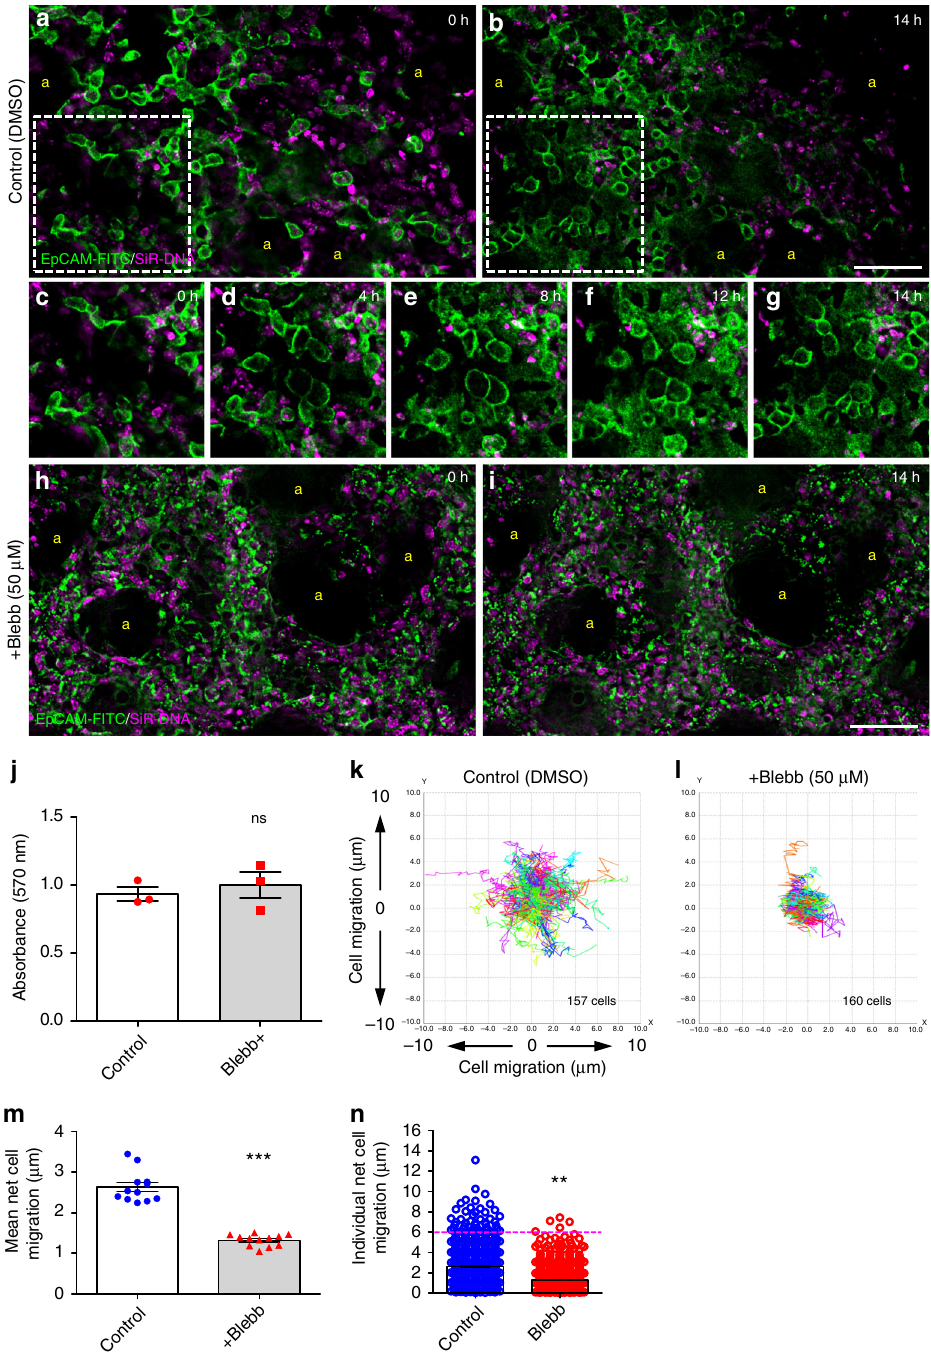
Fig. 6 Blebbistatin inhibits epithelial cell migration in PCLS. Deconvolved wide fi eld, single plane z-stack images from 14 h time-lapse videos (Supplementary movies 14A, B) of control ( a – g ) and blebbistatin-treated ( h , i ) P3 PCLS labelled with EpCAM-FITC (green) and SiR-DNA (magenta). Still images are taken from supplementary video 14A at 0 ( c ), 4 ( d ), 8 ( e ) 12 ( f ) and 14 ( g ) hours represent the white boxed regions in a and b . Scale bar = 50 µ m. MTT cell viability assay comparing control and blebbistatin-treated P3 PCLS at the end of time-lapse, ( j ), n = 3 independent experiments using three separate mice, with duplicate slices per condition, per experiment, ns = not signi fi cant; paired Student t -test. Individual cell tracking over 14 h in a single fi eld from P3 PCLS treated with control DMSO ( k ) or blebbistatin ( l ) containing media. Mean net epithelial cell migration in P3 control and blebbistatin-treated PCLS movies over 14 h ( m ). n = 3 independent experiments using three separate mice, with duplicate slices per condition, per experiment. Two fi elds were quanti fi ed per slice. Each dot represents mean net epithelial cell migration per fi eld. Individual net cell migration in blebbistatin treated vs. DMSO control P3 PCLS after 14 h of time-lapse imaging (each dot represents a single cell) ( n ). A total of 1243 cells for DMSO control and 1340 cells for blebbistatin-treated PCLS were tracked. n = 3 independent experiments using three separate mice, with duplicate slices per condition, per experiment. Two fi elds were quanti fi ed per slice. *** p < 0.0001, ** p = 0.001; Mann-Whitney U -test,. Yellow ‘ a ’ indicates alveolar airspaces. Error bars are de fi ned as